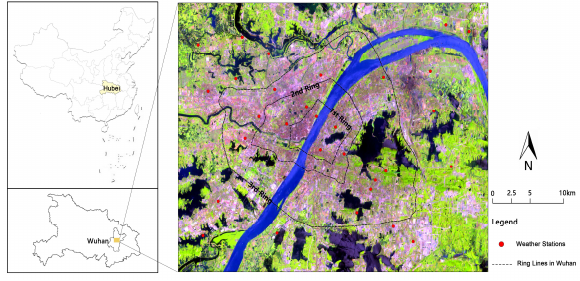
Fig 1. Study area and 30 weather stations